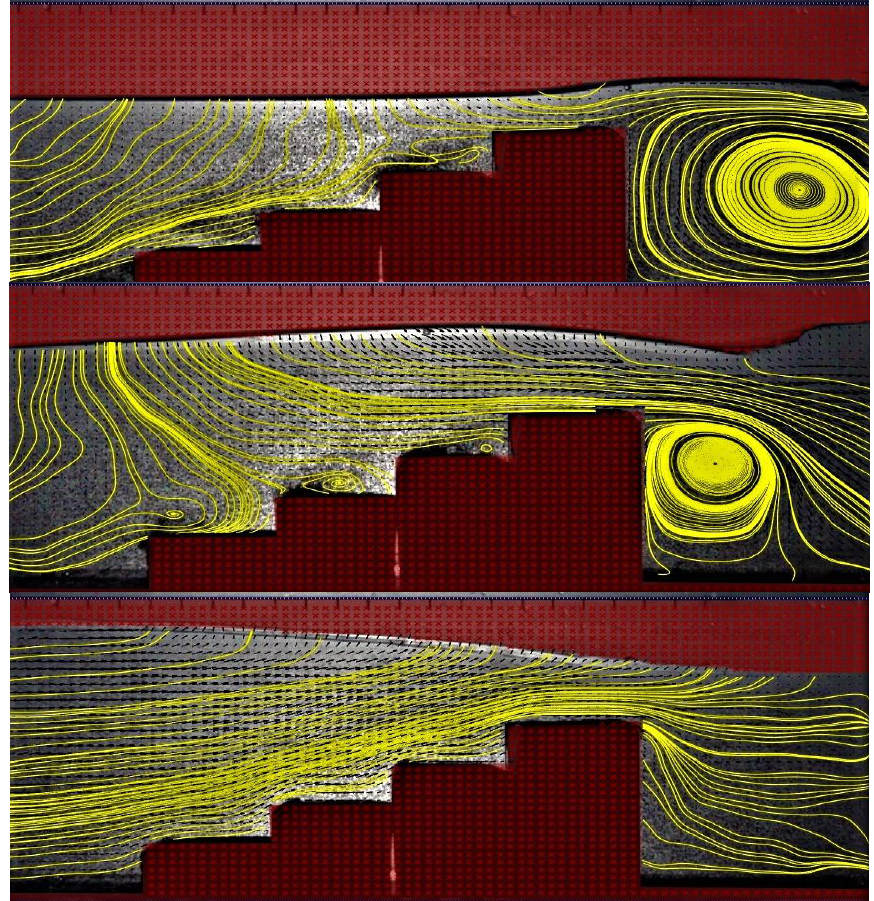
Figure 10. The streamline variation of a solitary-like wave propagating over a single set of the rectangular submerged breakwaters.